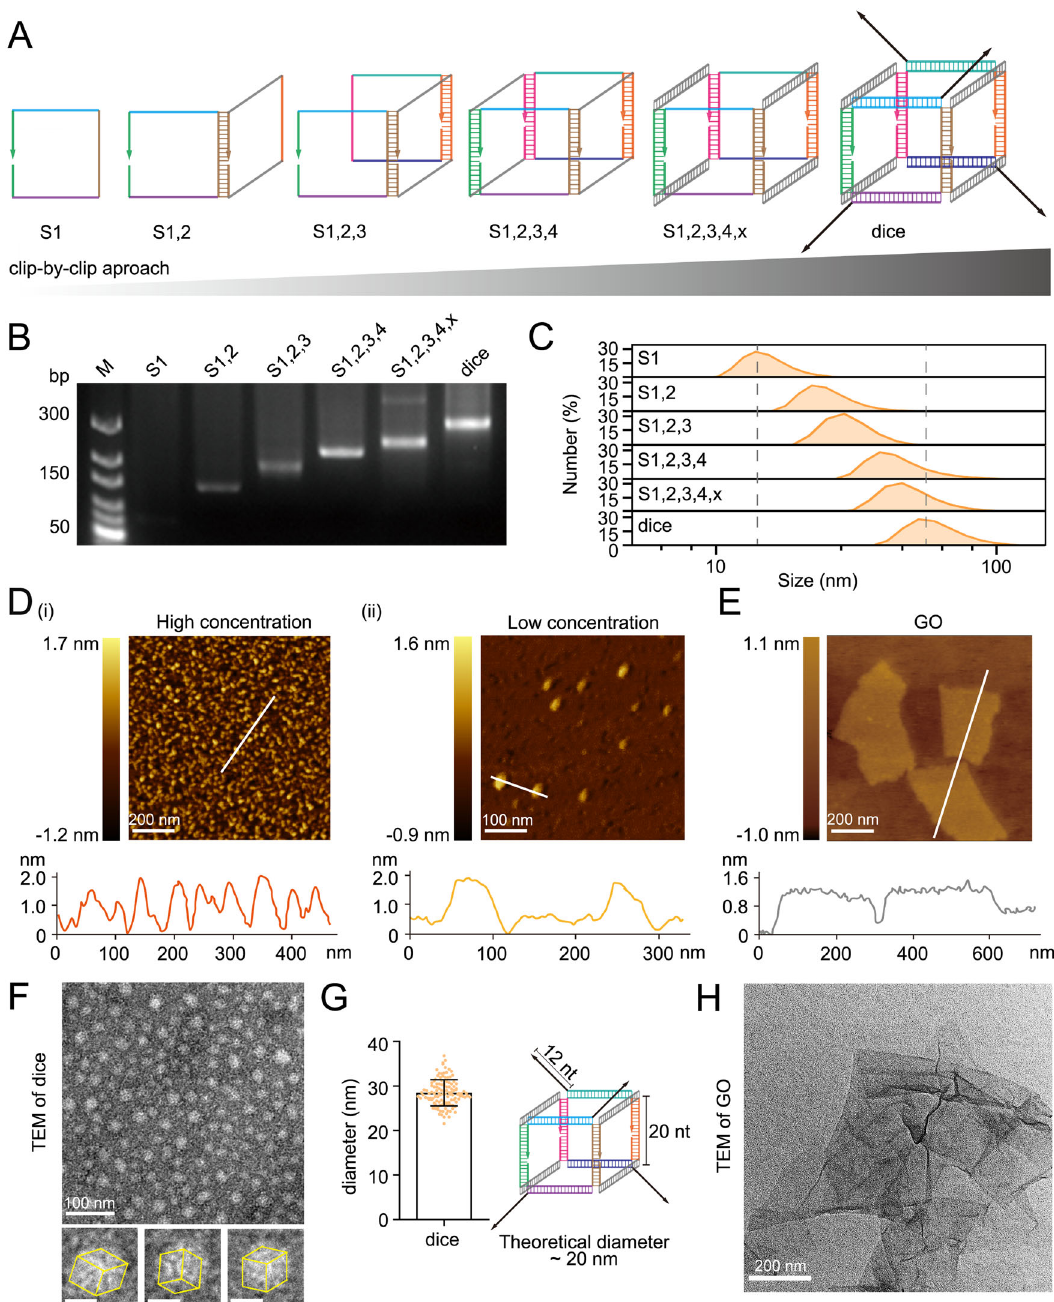
Fig. 2 | Assembly and characterization of the DNA nano-dice system. A Construction process of DNA nano-dice. B AGE characterization of DNA nano- dice from S1 to dice from 3 independent experiments. C DLS of nano-dice from S1 to dice. D AFM characterization of DNA nano-dice in high and low concentration from3independentexperiments.Thescalebarsare200and100nm,respectively. E AFM image of GO sheets deposited on mica substrates from 3 independent